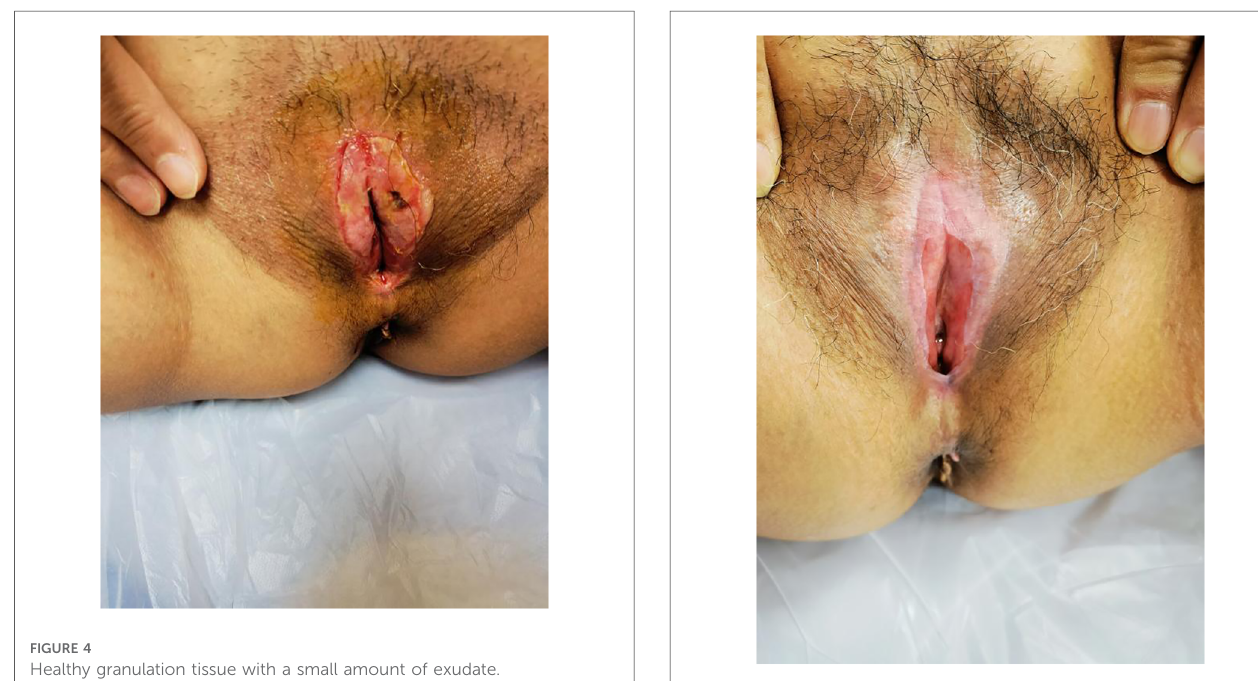
FIGURE 6 Three weeks after the operation the wound was basically